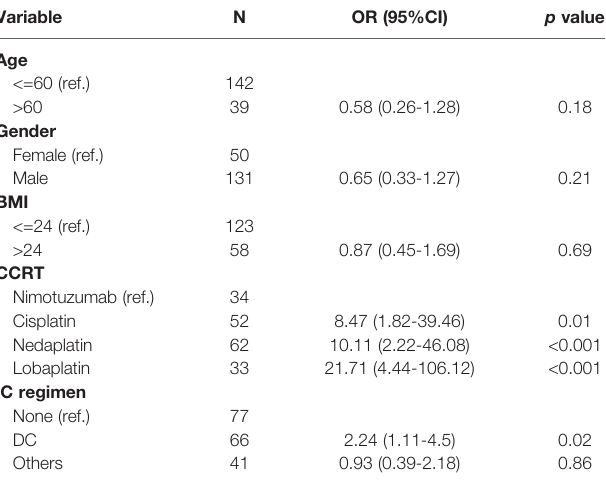
TABLE 5 | Risk factor associated with grade 3-4 hematological toxicities based on binary logistic regression. Variable N OR (95%CI) p value Age <=60 (ref.)